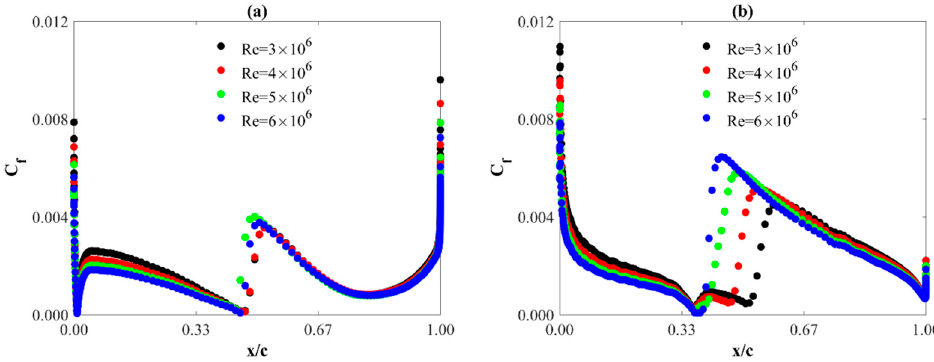
Figure 13. Skin friction coefficient at the angle of attack of 4°—Reynolds number effect for ( a ) the pressure side of the airfoil and ( b ) the suction side of the airfoil. These results are given for URANS with the Transition SST model.